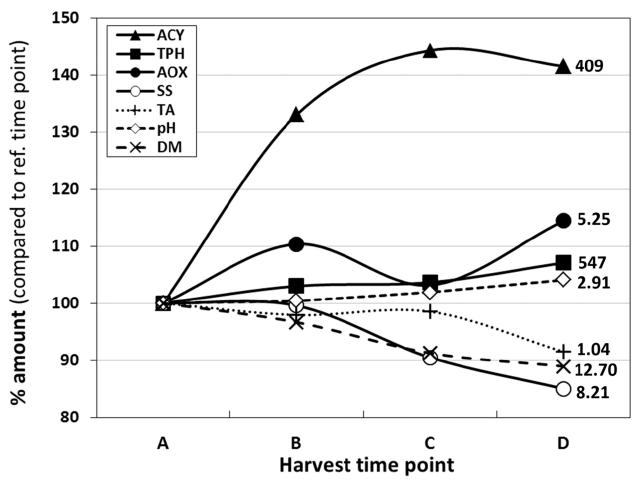
Fig. 3: Quality of mature berries sampled at location F8 (Tveter) in South- ern Norway. Curves depict within�season variation (% amount) at different harvest times based on average values from years 2008 to 2010. Mean values of quality parameters measured are quoted for the last time point (ACY and TPH in mg/100 g FW; AOX in mM/100 g FW; SS in °Brix; TA in g/100 g FW; DM in %).